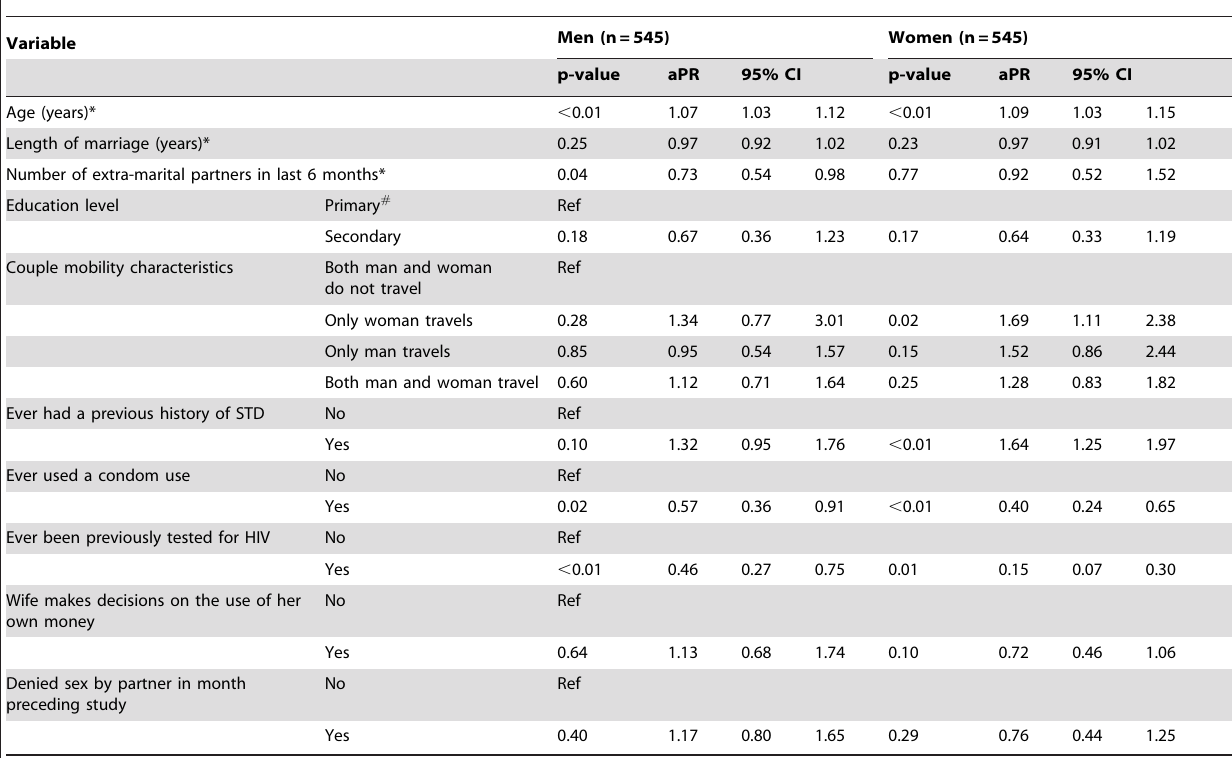
Table 2. Mobility as one of the determinants of HIV